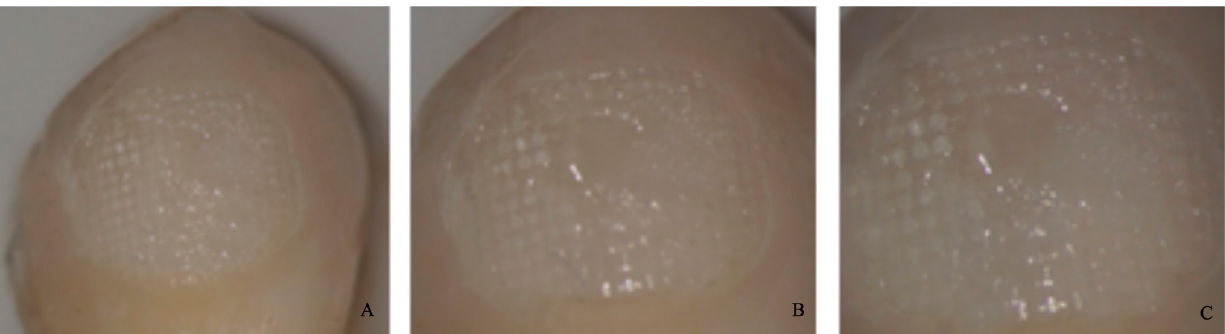
Figure 6. Score 2. ( A ) Magnification: 10 × 1; ( B ) Magnification: 10 × 1.6; ( C ) Magnification: 10 × 2.5.